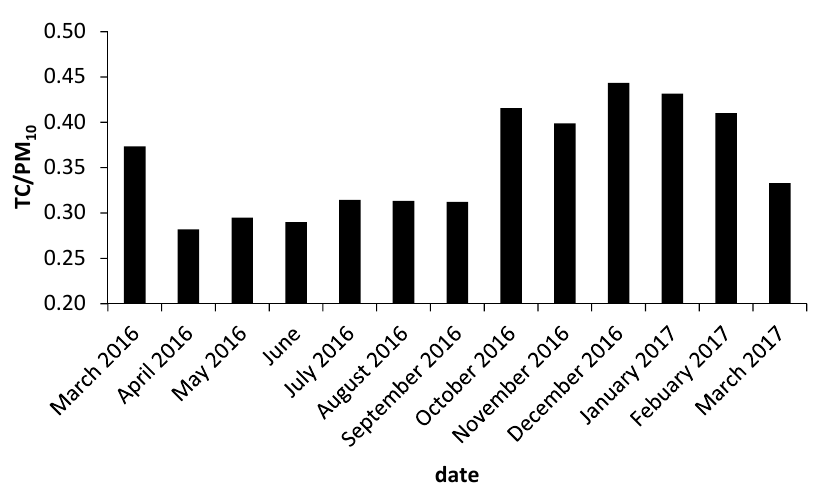
Figure 3. Monthly mean variation of the TC/PM 10 ratio.